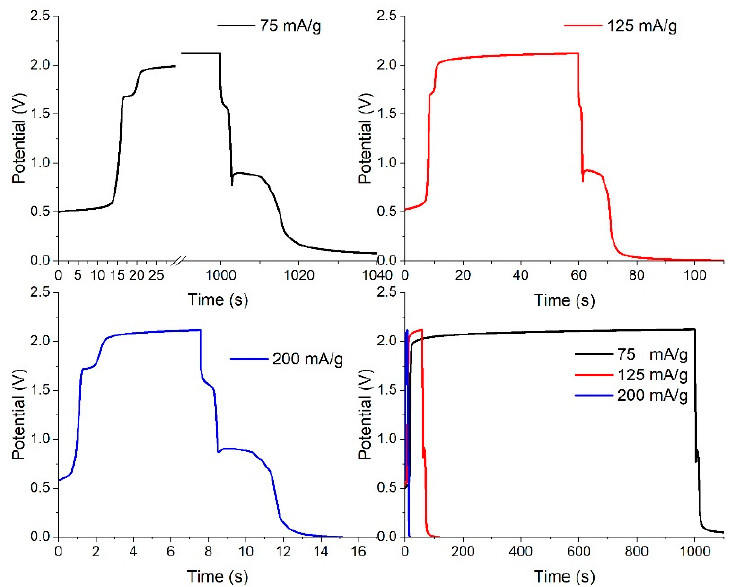
Figure 11. Charge–discharge curves of a dealloyed glassy alloy ribbon sample at different constant currents.